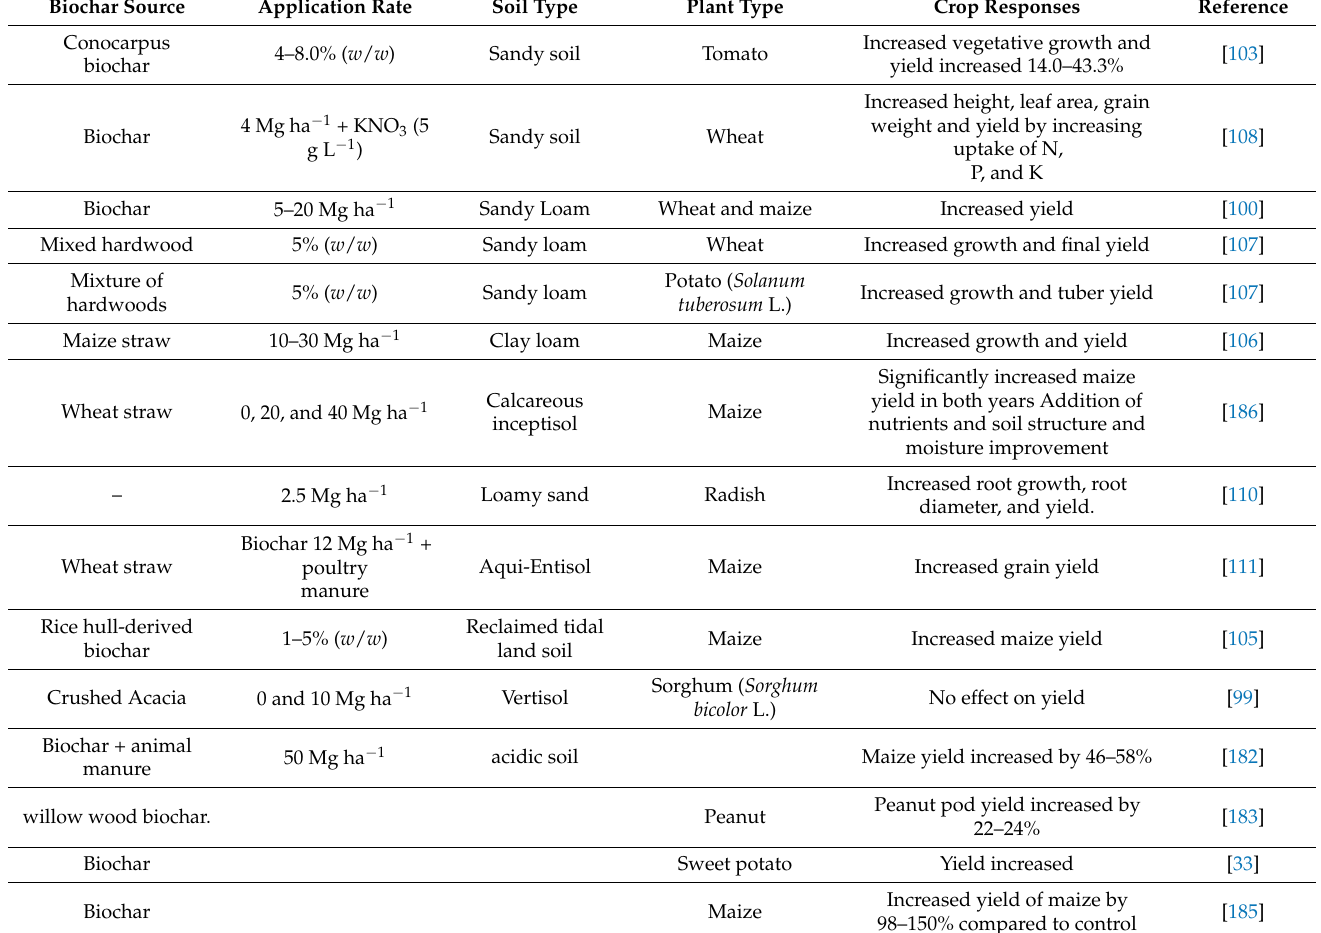
Table 4. Effect of biochar on plant growth and